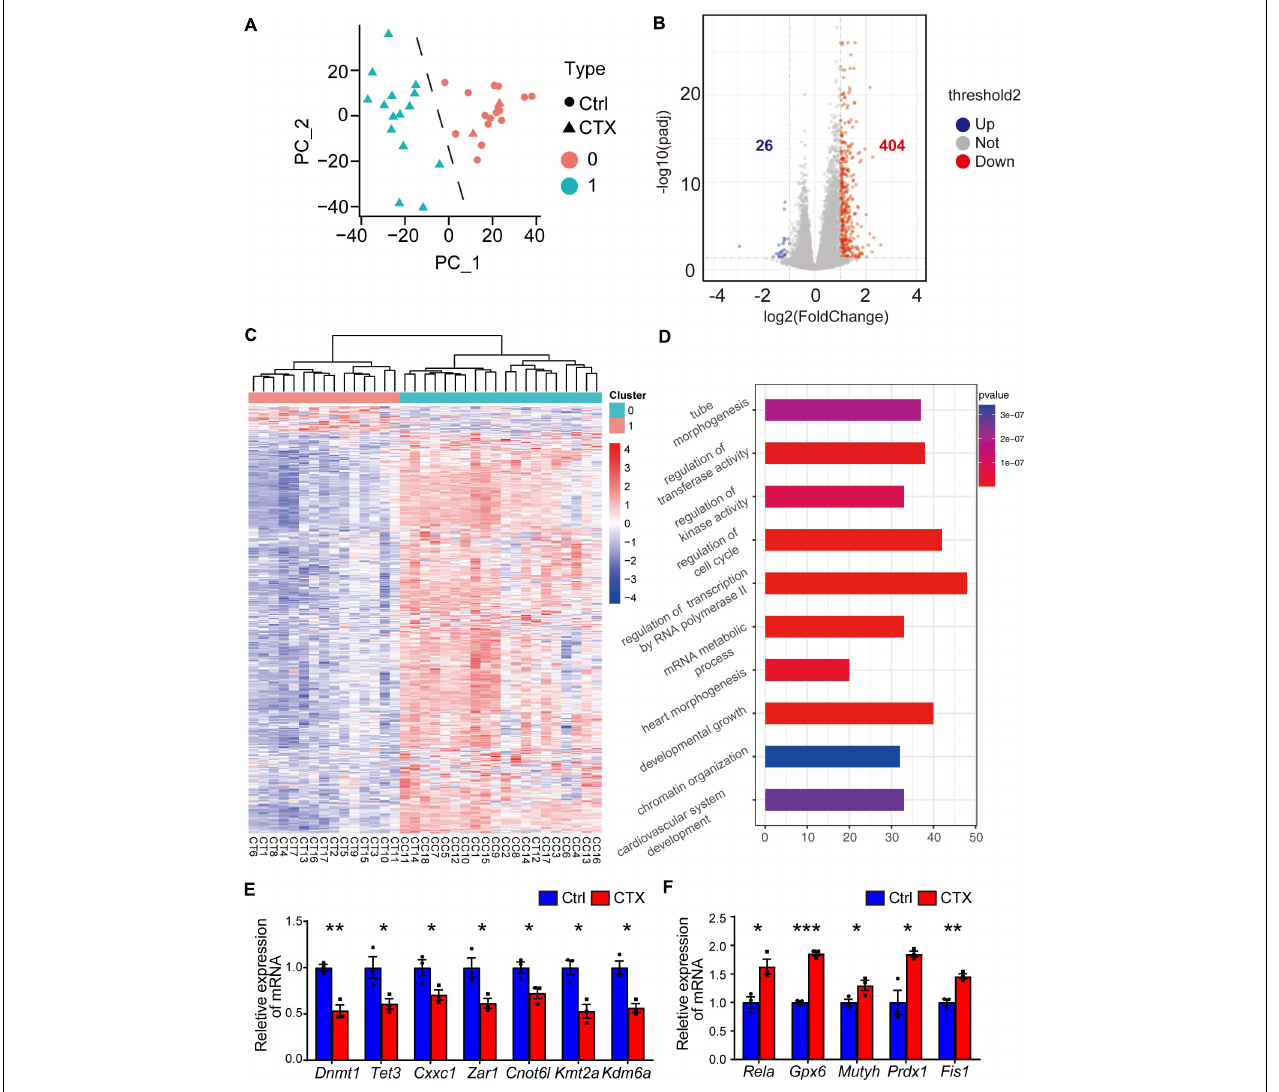
FIGURE 5 | Single-cell RNA transcriptional profiling of oocytes within/without CTX early maternal exposure. (A) Principal component analysis (PCA) exhibiting the distinguishing clusters of samples from two groups. (B) Volcano plots with differentially expressed genes are shown. ( p < 0.05 and log2-fold change > 1). (C) Heatmap of all the up- and down-regulated genes with the most significant fold change between the two clusters. There were 2 samples from the CTX group divided into Cluster 0. (D) GO analysis of highly expressed genes enriched in Cluster, which is downregulated in CTX-exposed oocytes. (E–F) RT-qPCR analysis of some typical down- and up-regulated genes in single-cell RNA-seq. Data was presented as mean ± SEM. * P < 0.05, ** P < 0.01, *** P < 0.001.